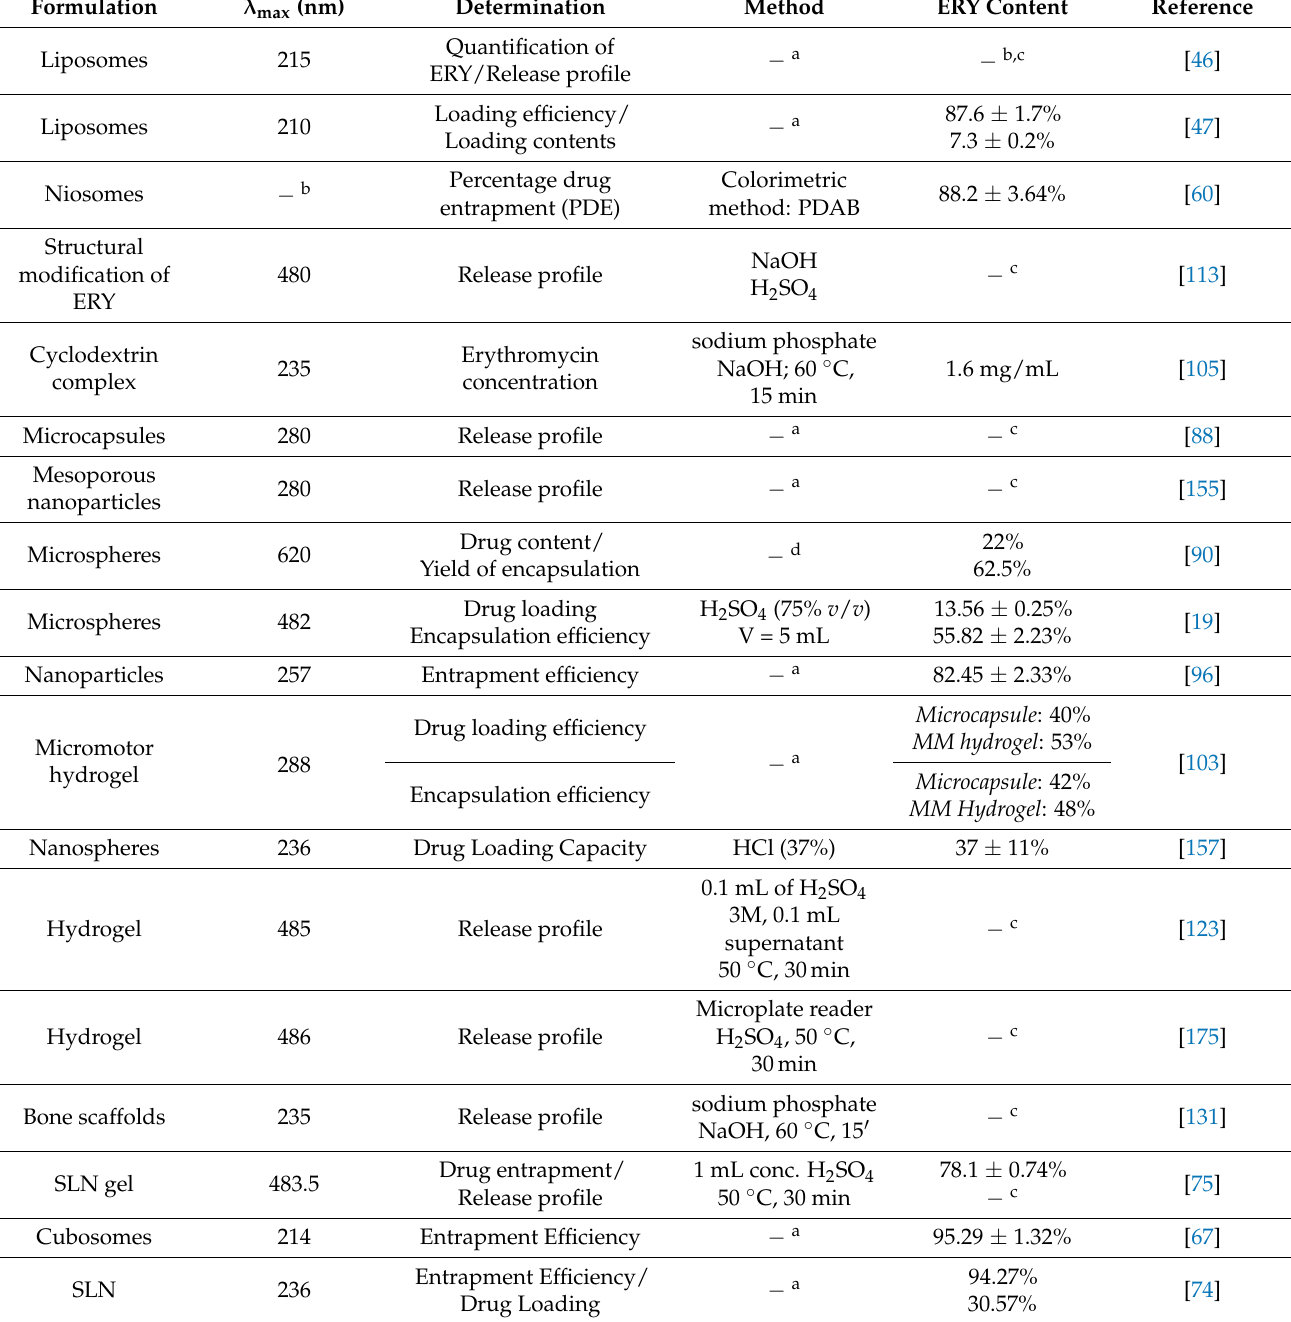
Table 2. ERY quantification by UV–VIS spectrophotometry for various